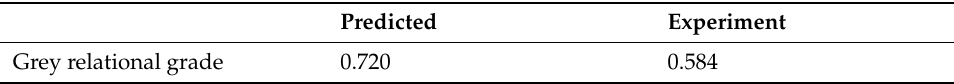
Table 2. Results of confirmation experiment. Predicted Experiment Grey relational grade